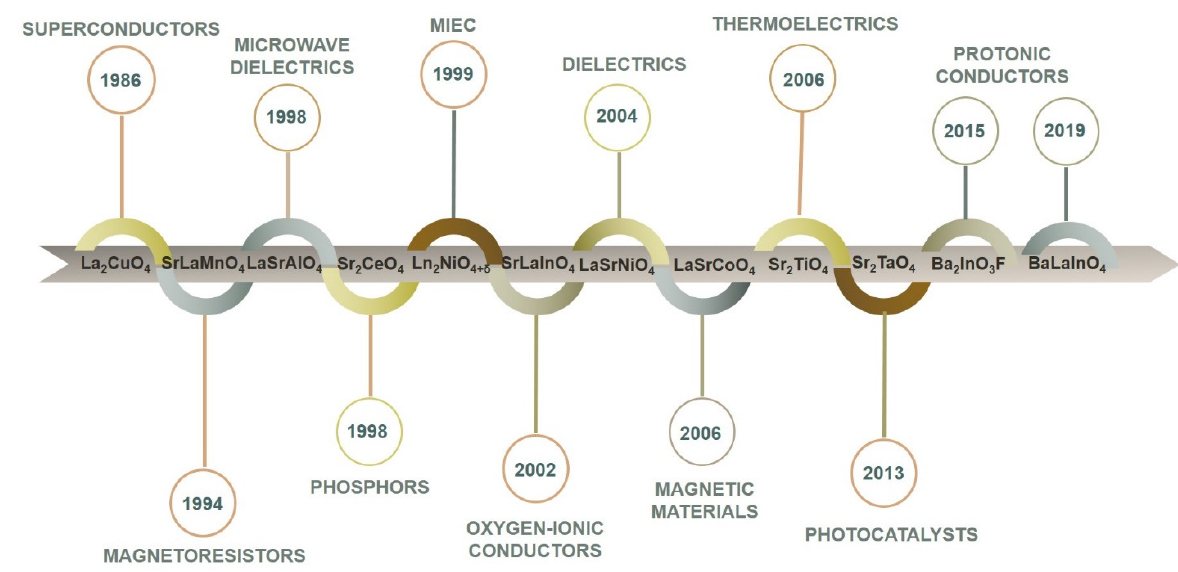
Figure 2. Historical overview on the investigation of the materials with Ruddlesden–Popper structure.